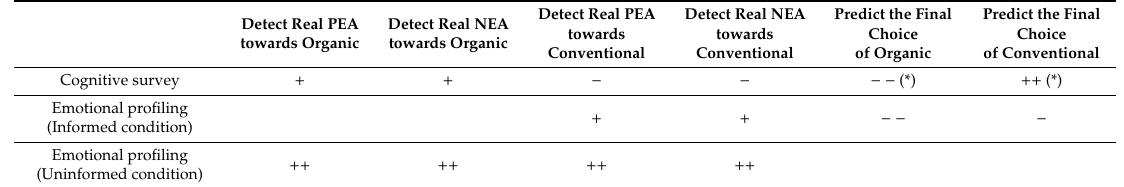
Table 5. The strength of the di ff erent applied methods in predicting emotion attitudes and final choice behavior of organic vs. conventional food or samples. (*) represents the significant results. Detect Real PEA Detect Real NEA Predict the Final Predict the Final Detect Real PEA Detect Real NEA towards towards Choice Choice towards Organic towards Organic Conventional Conventional of Organic of